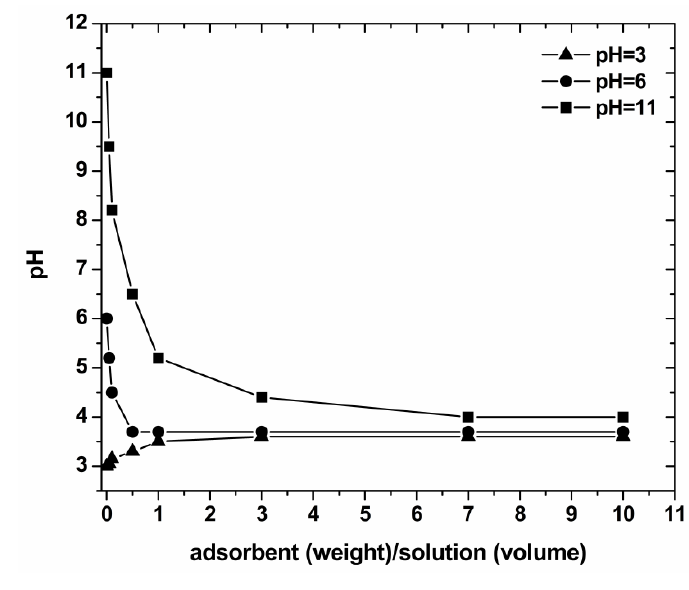
Figure 3. Determination of the point of zero charge (PZC) of the